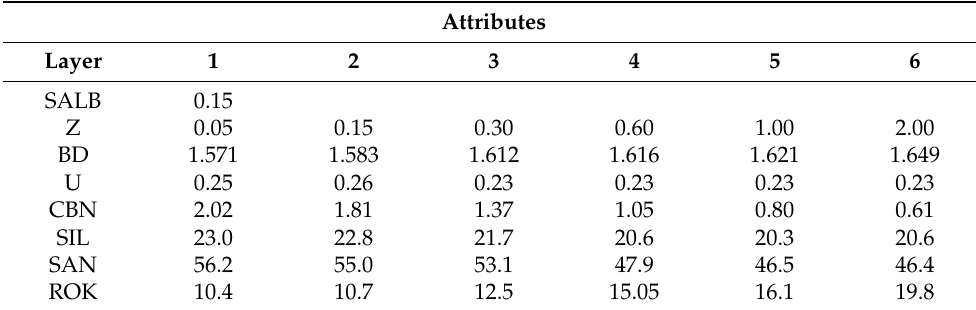
Table 5. Altered soil parameters used for cocoa simulations in Ghana [45] SALB is soil albedo, Z is depth (m), BD is bulk density (Mg/m 3 ), U is wilting point (m/m), CBN is organic carbon (%), SIL is silt content (%), SAN is sand content (%), ROK is coarse fragment content